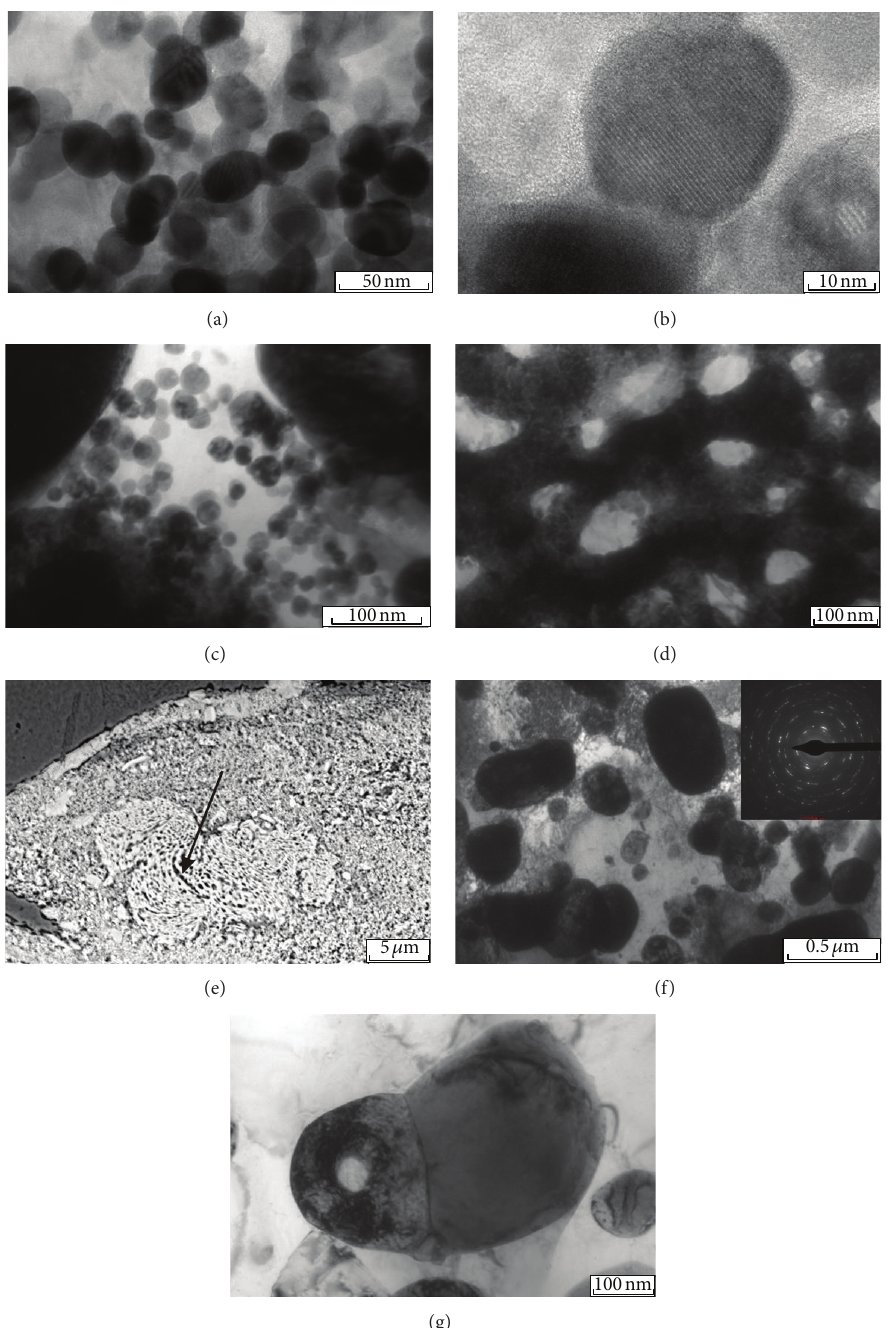
Figure 3: Structure of the intermediate layer with a heterophase structure after explosive welding of copper and tantalum plates (a–e) and after heating for 1 hour at 900 ∘ C (f, g). (e) is a scanning electron micrograph, and the other images are transmission electron